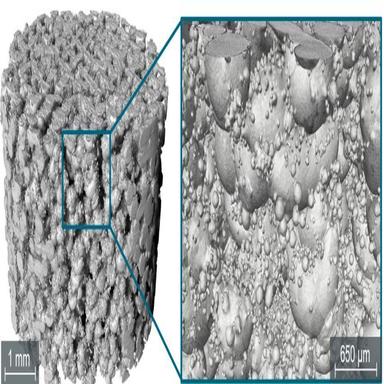
3D representation (rendering) of one sample with notable remaining powder particles at the surface.